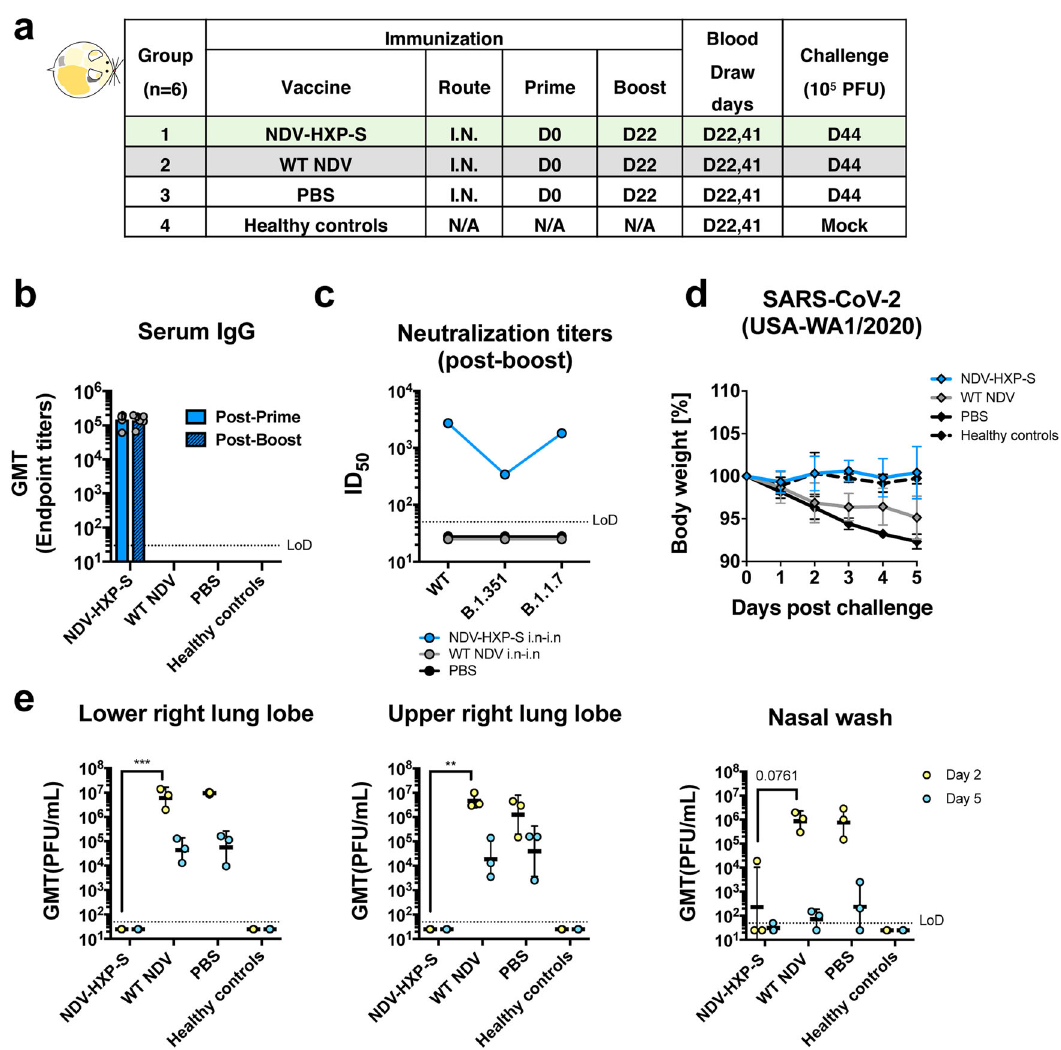
Fig. 5 Live NDV-HXP-S via the intranasal route induces protective antibody responses in hamsters. a Design of the study. Eighteen-to-twenty-week- old female Golden Syrian hamsters were used. Group 1 ( n = 6) was vaccinated with 10 6 EID 50 of live NDV-HXP-S. Group 2 ( n = 6) was vaccinated with 10 6 EID 50 of live WT NDV as the vector-only control. Group 3 ( n = 6) was vaccinated with PBS as the negative control. Group 4 ( n = 6) were the healthy controls. The vaccine was administered via the intranasal (I.N.) route at D0 and D22. Blood was collected at D22 and D41. Group 1 – 3 were challenged with 10 5 PFU of the USA-WA1/2020 strain at D44. Group 4 was mock-challenged with PBS. b Spike-speci fi c serum IgG. Antibodies in post-prime (D22, solid blue bar) and post-boost (D41, pattern blue bar) sera were measured by ELISAs. GMT endpoint titers were graphed. The error bars represent geometric SD. c Neutralizing activity of serum antibodies. Post-boost sera from groups 1 – 3 were pooled within each group and tested in neutralization assay against USA-WA/2020 strain (WT), B.1.351 variant, and B 1.1.7 variant in technical duplicate. Serum dilutions inhibiting 50% of the infection (ID 50 ) were plotted (LoD = 1:50; An ID 50 = 1:25 was assigned to negative samples). d Body weight change of hamsters. Bodyweight was recorded for 5 days after the challenge. The error bars represent geometric SD. ( c and d , blue: NDV-HXP-S; gray: WT NDV; black: PBS) e Viral load in the lungs and nasal washes. The lower right and upper right lung lobes of a subset of animals ( n = 3) from each group were collected at day 2 (yellow) and day 5 (blue) post challenge. Each lung lobe was homogenized in 1 mL PBS. Nasal washes were collected in 0.4 mL of PBS. Viral titers were measured by plaque assay on Vero E6 cells and plotted as GMT of PFU/mL (LoD = 50 PFU/mL; a titer of 25 PFU/mL was assigned to negative samples). The error bars represent geometric SD. Statistical difference was analyzed by two-way ANOVA corrected for Dunnett ’ s multiple comparisons test (** p < 0.0017; *** p =